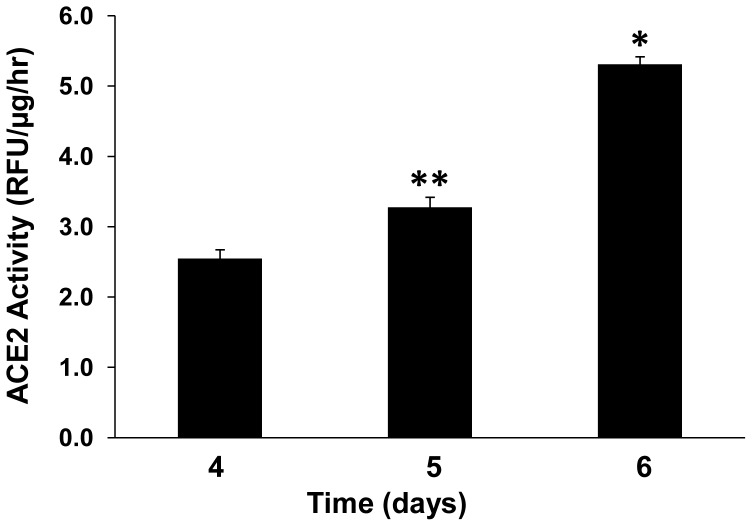
Increased ACE2 activity in media from mouse proximal tubular cells.A time-dependent increase in ACE2 activity occurred in the cell media. Results are means ± SE, corrected for total cell protein from culture dishes set up in parallel to those where media was analyzed for ACE2 activity on three successive days. *P<0.001 vs day 4 and day 5, and **P<0.01 vs day 4, n = 4.